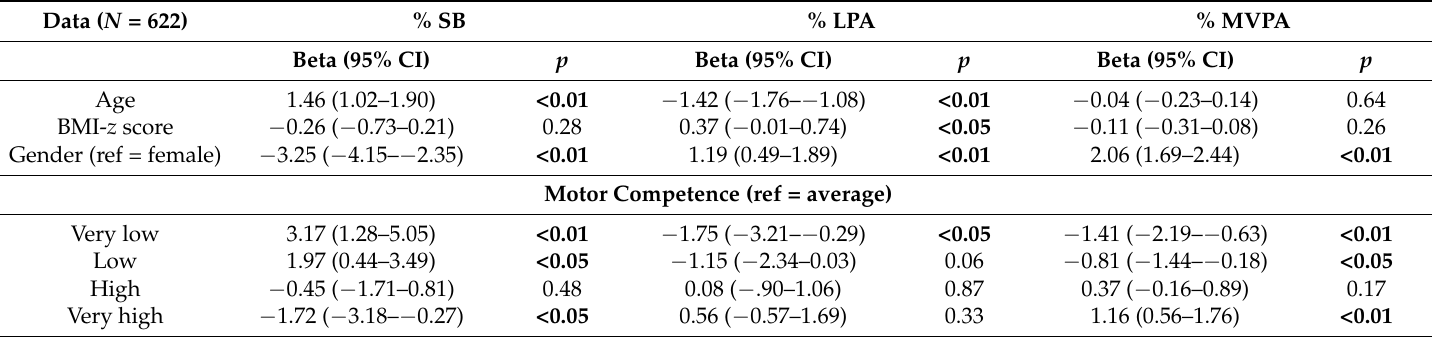
Table 2. Associations between MC, BMI z -score, age, gender, and percentage of time spent in SB, LPA and MVPA on an average school